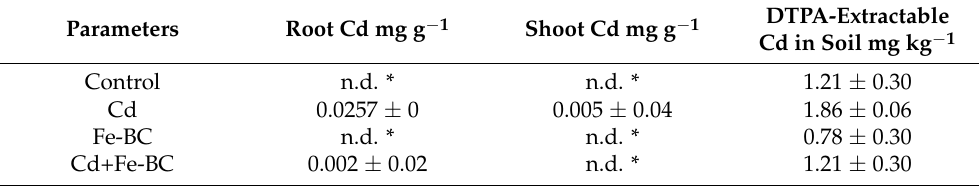
Table 2. Cd concentration in root and shoot, along with diethylenetriamine pentaacetic acid (DTPA)- extractable Cd in soil under different treatments (control, Cd, Fe-BC, Cd+ Fe-BC) were measured after harvesting of radish